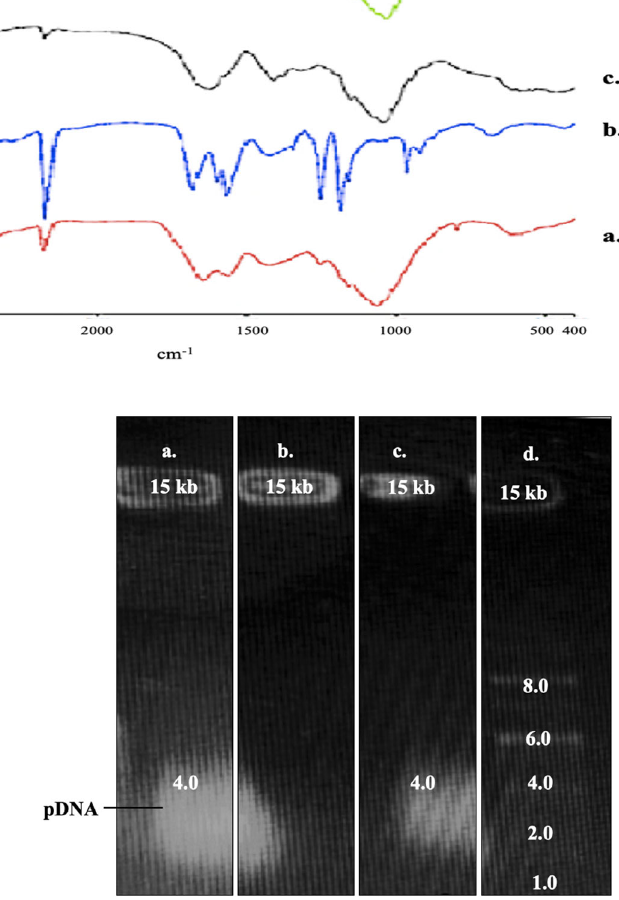
Fig. 5 Gel electrophoresis of ( a ) plasmid DNA, ( b ) formulation P3, ( c ) formulation P4 and ( d ) standard